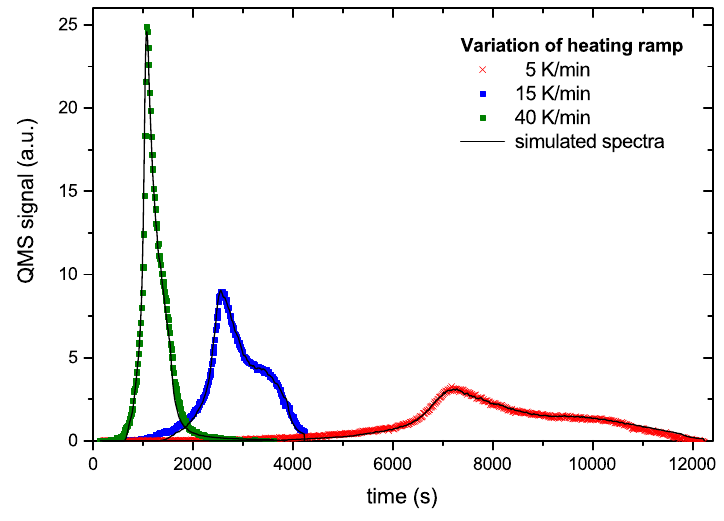
Figure 8. Comparison of experimental (symbols) and model data (lines) as a function of time for 3 selected temperature